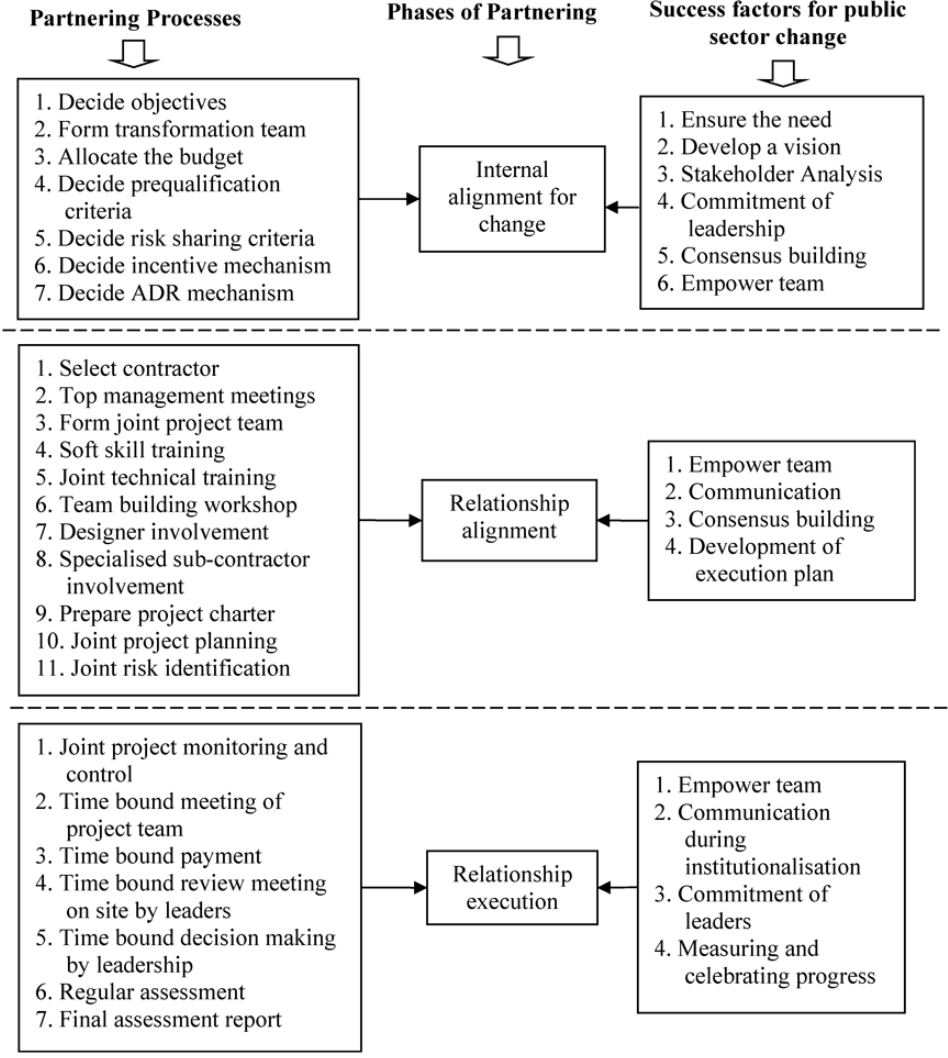
RC conceptual model (RCCM) for public sector construction organizations